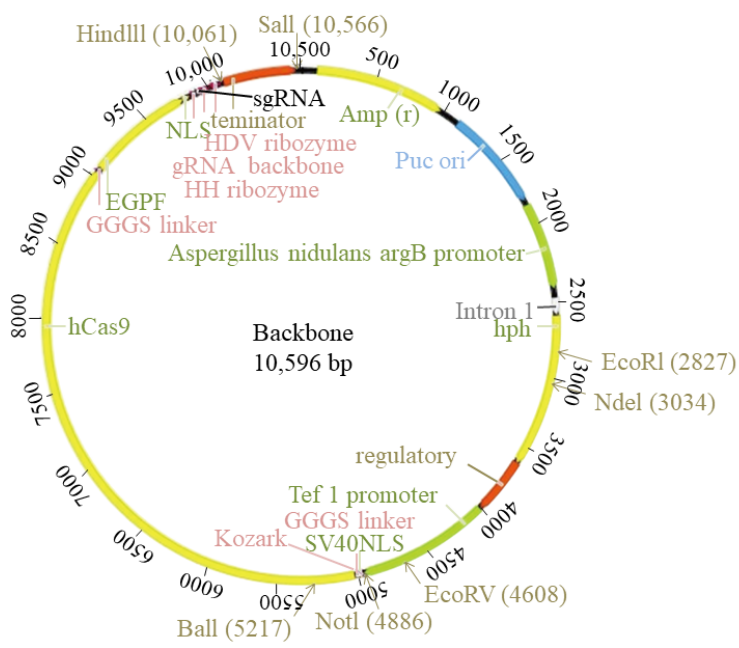
Figure 1. CRISPR-Cas9-based gene disruption all-in-one circular plasmid.